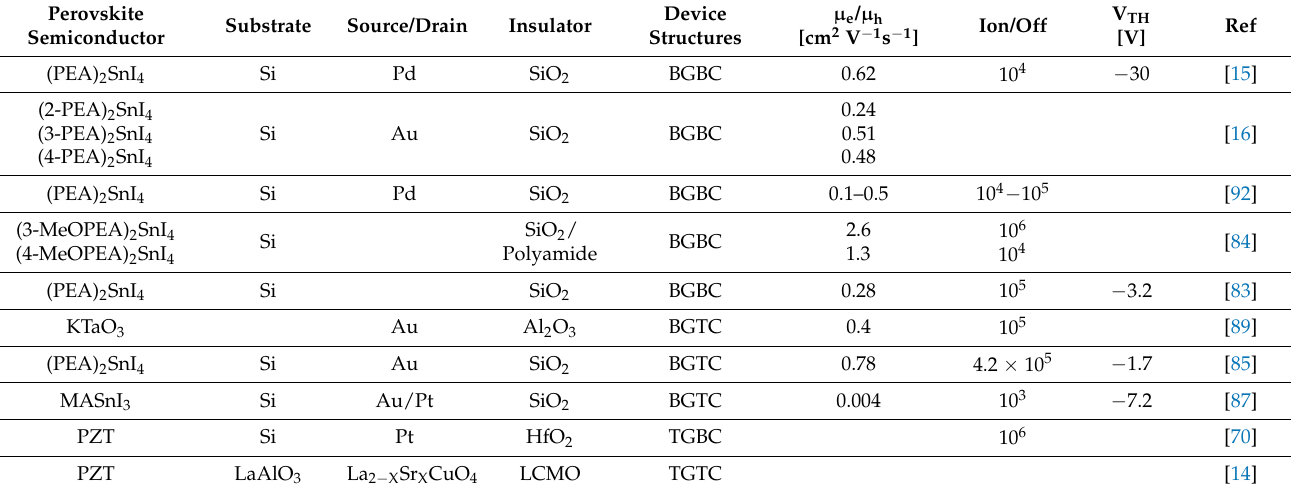
Table 1. Early works of thin-film FETs with the perovskite-material-based channels in the literature. Perovskite